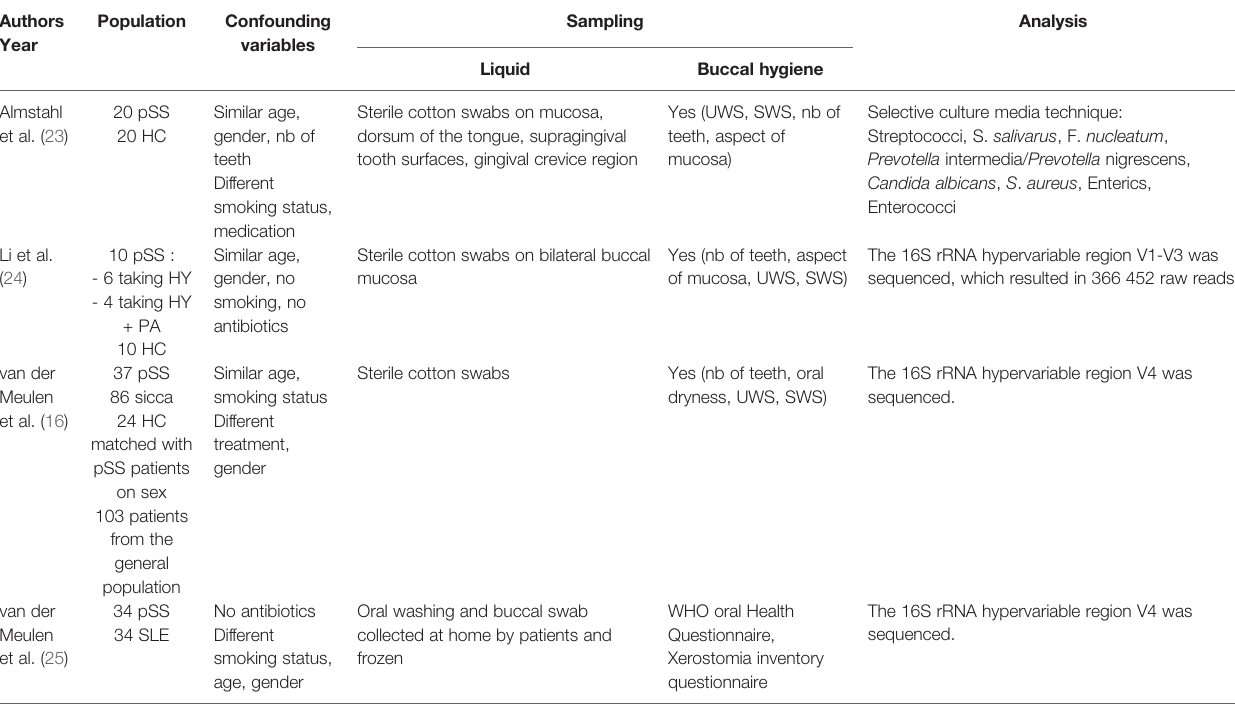
TABLE 2 | Analysis of the methodology of the included studies relying on buccal swabs in pSS patients compared to HCs and sicca patients. Authors